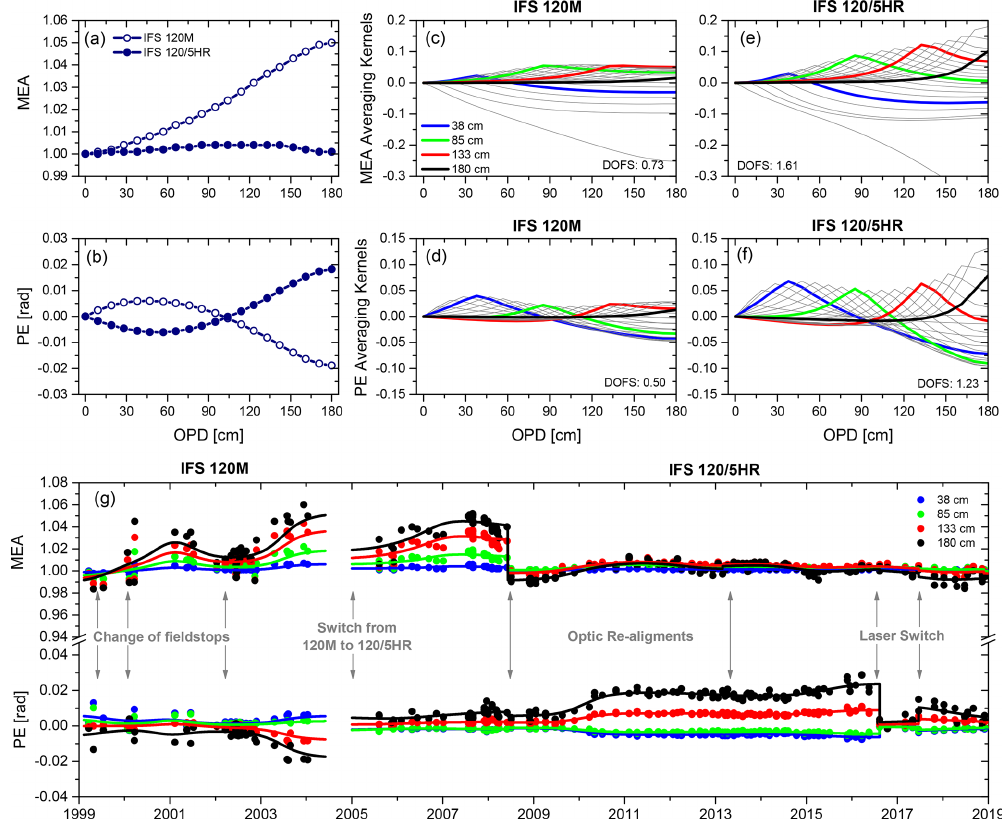
Figure 1. Example of the (a) normalized MEA and (b) PE (rad) retrievals as a function of the OPD for the IFS 120M (N 2 O cell measurement taken on 3 July 2003) and for the IFS 120/5HR (N 2 O cell measurement performed on 20 March 2013). (c, d) Averaging kernel rows of the MEA and PE retrievals for the cell example of the IFS 120M. Panels (e, f) are the same as (c) and (d) but for the IFS 120/5HR. The degrees of freedom for signal (DOFS) are also shown. (g) Time series of the normalized MEA and PE values at four OPD (38, 85, 133 and 180cm) between 1999 and 2018. Data points represent individual N 2 O cell measurements, and solid lines depict the smoothed MEA and PE curves. The solid grey arrows indicate punctual interventions made regarding the IZO FTIR instruments: the changes in the field stop instruments between 1999 and 2004, there is a switch from the IFS 120M to the IFS 120/5HR in January 2005, optical re-alignments are performed in June 2008 and February 2013, and internal laser replacements are performed in August 2016 and June 2017. (g) Adapted from García et al.